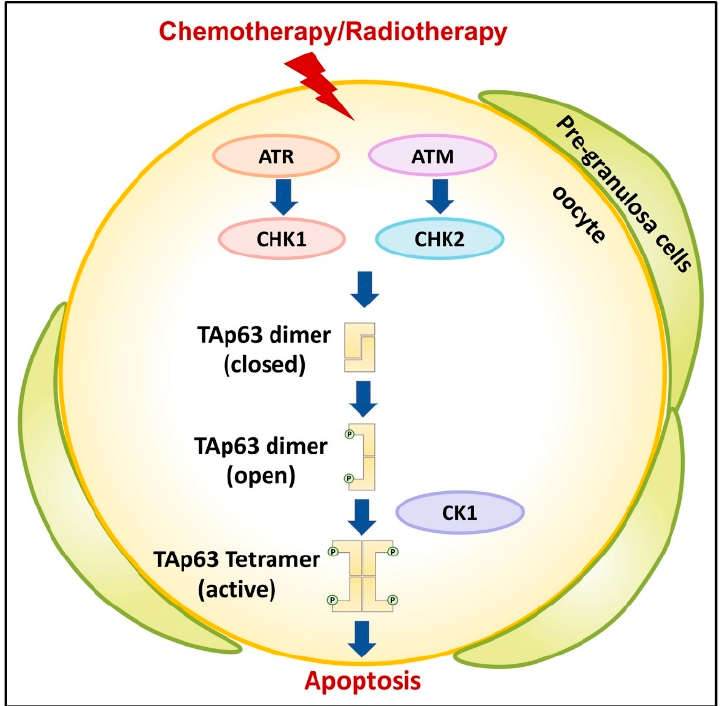
Figure 3. TAp63 is integral for DNA damage signaling in oocytes. Chemotherapy or radiotherapy activates the ATM/CHK2 or the ATR/CHK1 pathway. The phosphorylation of TAp63 by priming kinase CHK1/2 recruits a second executioner kinase CK1, which adds additional phosphorylation. This allows the opening of the closed dimeric state to eventually form an active tetrameric conformation. TAp63 acts as a transcriptional activator for downstream apoptotic signaling.